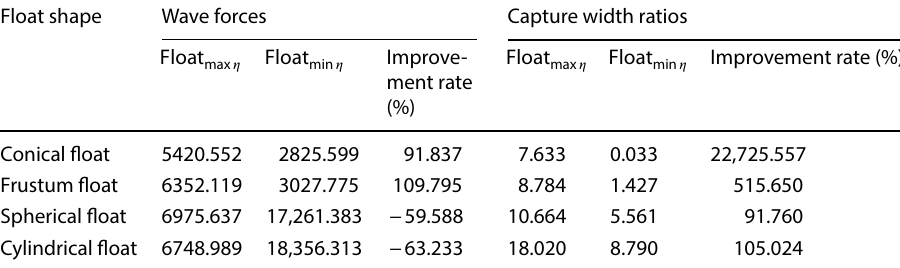
Float shape Wave